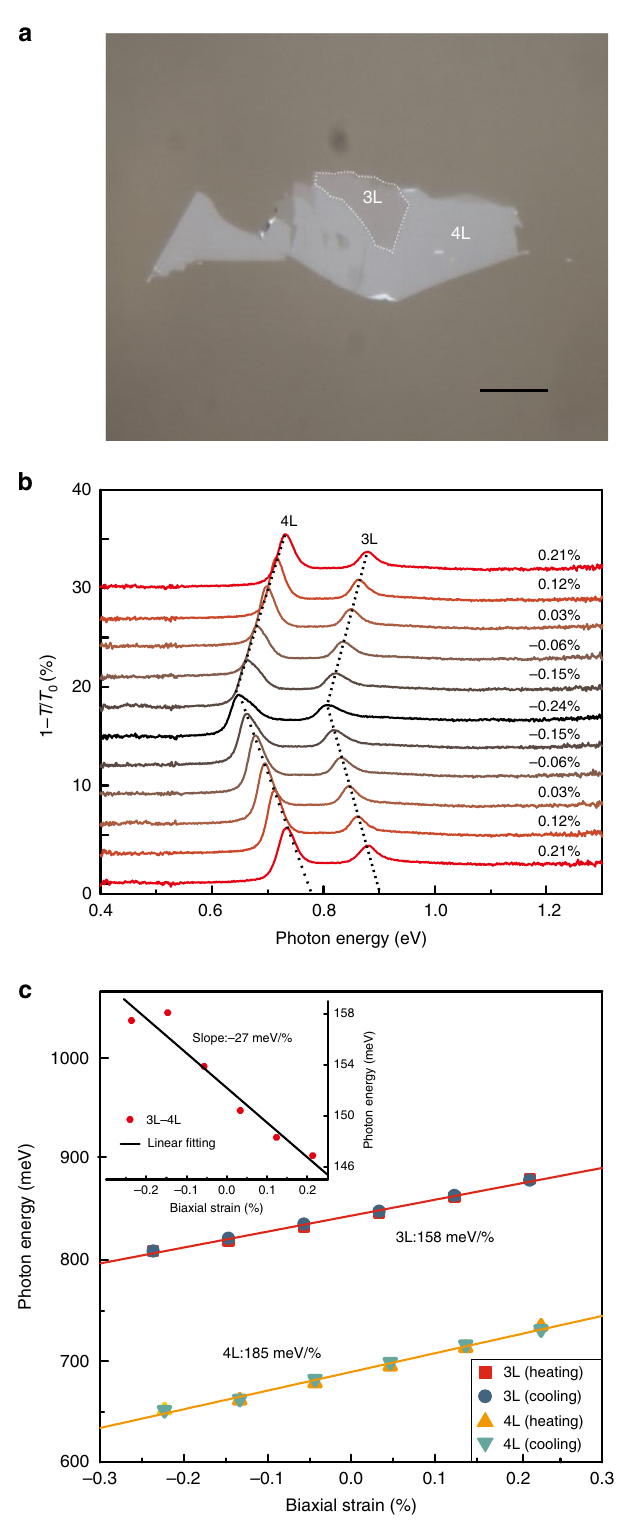
prominent peaks can be observed, labeled as E 11 (transition from the fi rst valence band v 1 to the fi rst conduction band c 1 ) and E 22 transitions (v 2 to c 2 ), as indicated in the inset of Fig. 1b. Biaxial tensile (compressive) strain was introduced to the BP sample through heating (cooling) and strain value was deter- mined according to the experimentally measured thermal expansion coef fi cient of PP substrate (see Supplementary Figs. 1